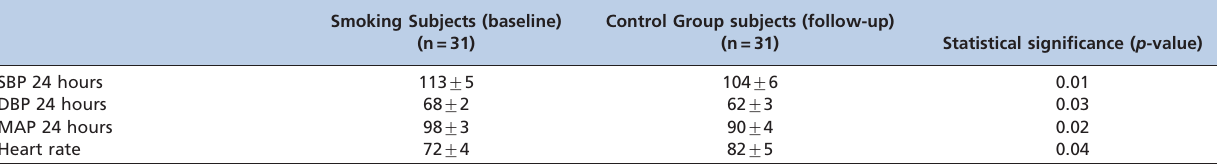
Table 3 - Twenty-four-hour ambulatory blood pressure monitoring data (before smoking vs. controls). Smoking Subjects (baseline)